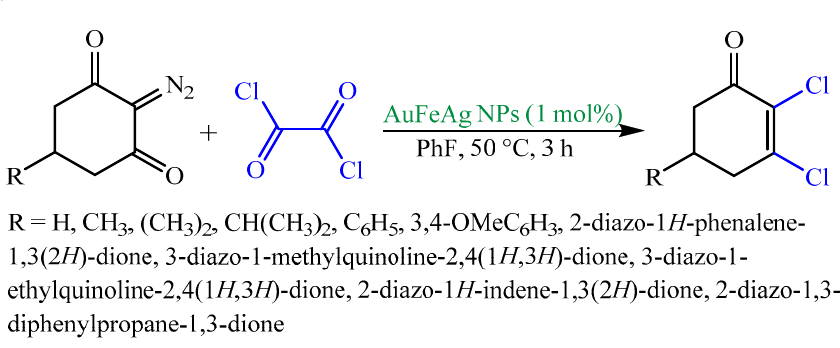
Figure 8. ( a ) Role of A. membranaceus for the Au ‐ Fe ‐ Ag NPs formation. ( b ) High ‐ resolution TEM (HRTEM) image of Au ‐ Fe ‐ Ag NPs with D ‐ spacing. Reproduced from [108], with permission from Elsevier, 2015.